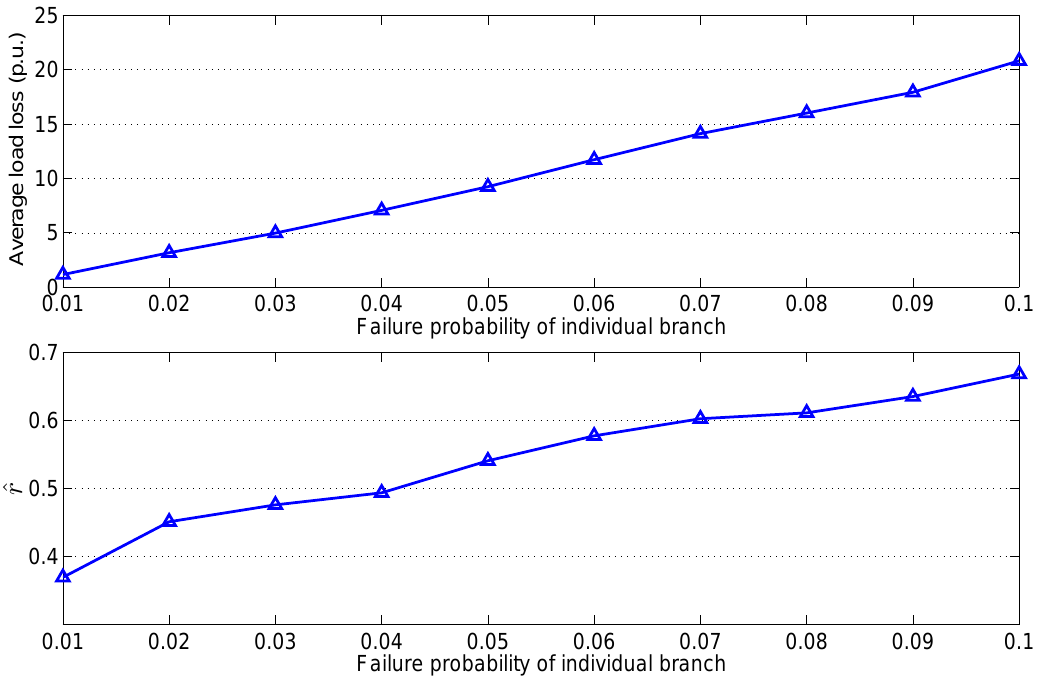
Figure 9. Average ratio of frequency insecurity-induced load loss to the total load loss under different p